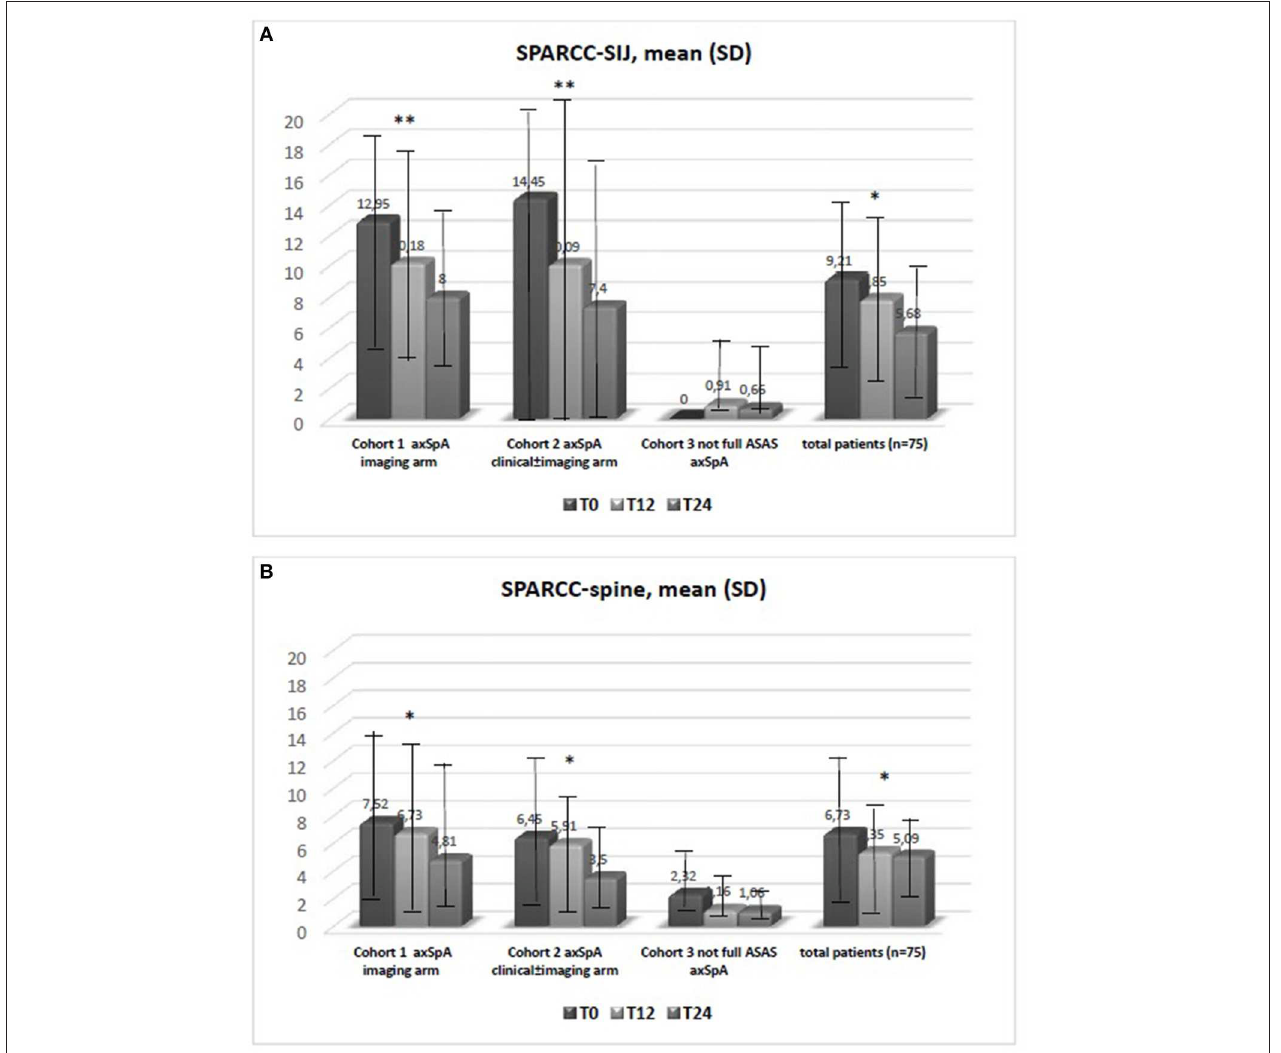
FIGURE 1 | (A,B) Data are expressed as mean SD. The test kruskal wallis repeated measures test and Dunn’s multiple comparison test were used. * p < 0.01 vs. T0, ** p < 0.001 vs. T0. Spondyloarthritis Research Consortium of Canada (SPARCC); sacroiliac joint (SIJ).